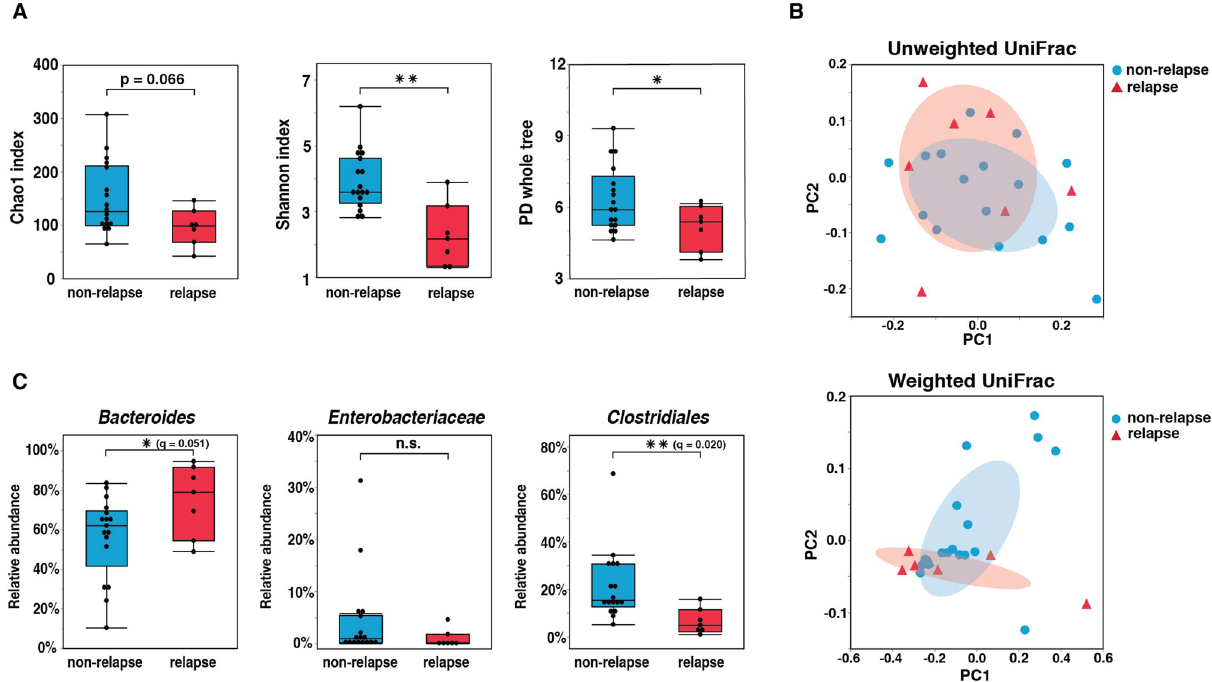
Figure 2. Comparison of gut microbiota composition in endoscopic remission group between non-relapse and relapse groups according to later clinical course. ( A ) Comparisons of α-diversity of gut microbiota composition between non-relapse (n = 17) and relapse (n = 7) groups as assessed by the Chao1 index, the Shannon index, and whole-tree phylogenetic diversity (PD). (B) Principal coordinate analysis of gut microbiota by unweighted and weighted UniFrac between non-relapse (n = 17) and relapse (n = 7) groups. Each ellipse indicates 50% probability. Unweighted (PERMANOVA, p < 0.0001) and weighted (PERMANOVA, p = 0.033) distances were significantly different. (C) Comparisons of taxonomic composition of microbiota including Bacteroides, Enterobacteriaceae, and Clostridiales between non-relapse (n = 17) and relapse (n = 7) groups. *Statistically significant difference between the 2 indicated groups ( p < 0.05). **Statistically significant difference between the 2 indicated groups ( p < 0.01). n.s., no significant difference between the 2 indicated